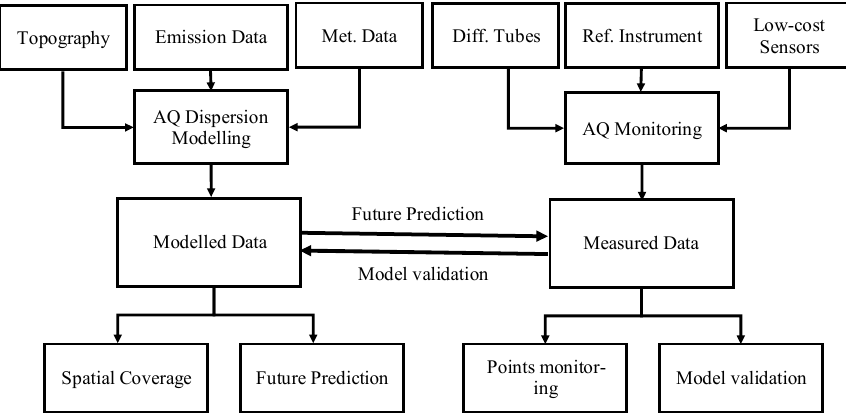
Figure 1. Schematic diagram comparing air quality modelling and monitoring and how they support each other.